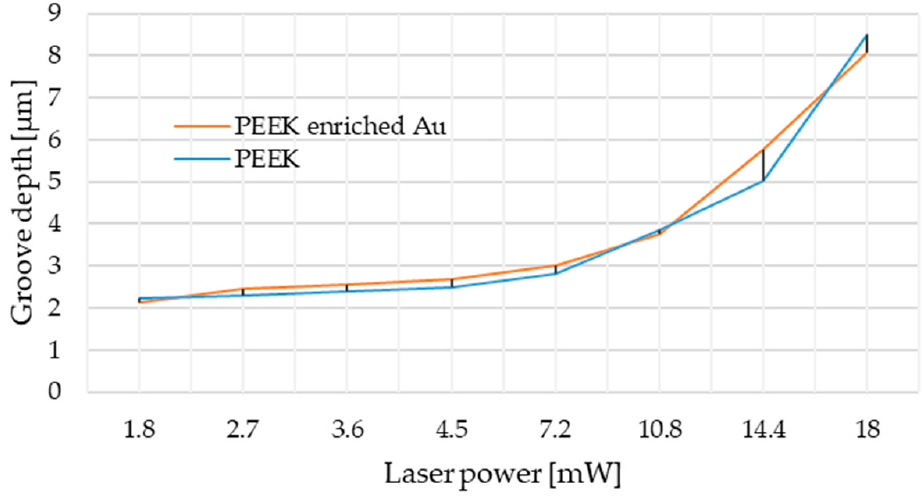
Figure 3. Power depth laser diagram based on confocal system analysis.